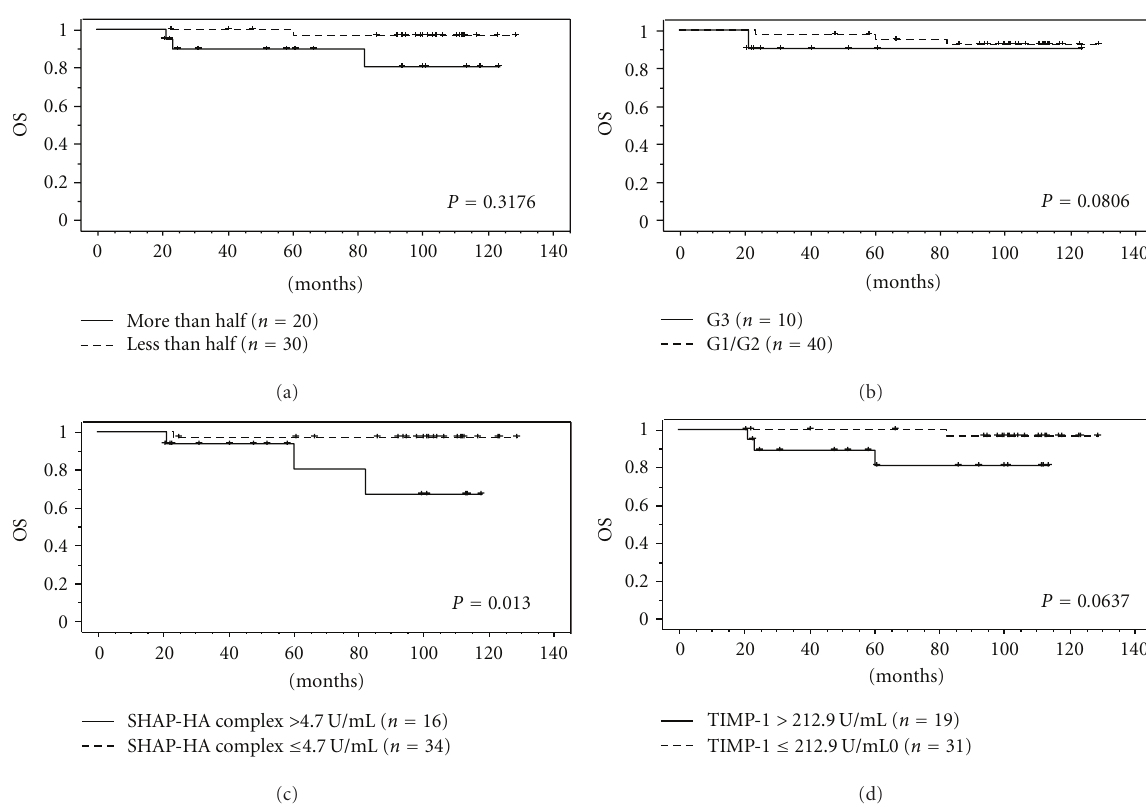
Figure 3: Overall survival in endometrial cancer patients was analyzed by the Kaplan-Meier method and log-rank test. The patients with elevated serum level of the SHAP-HA complex had a significantly shorter overall survival.